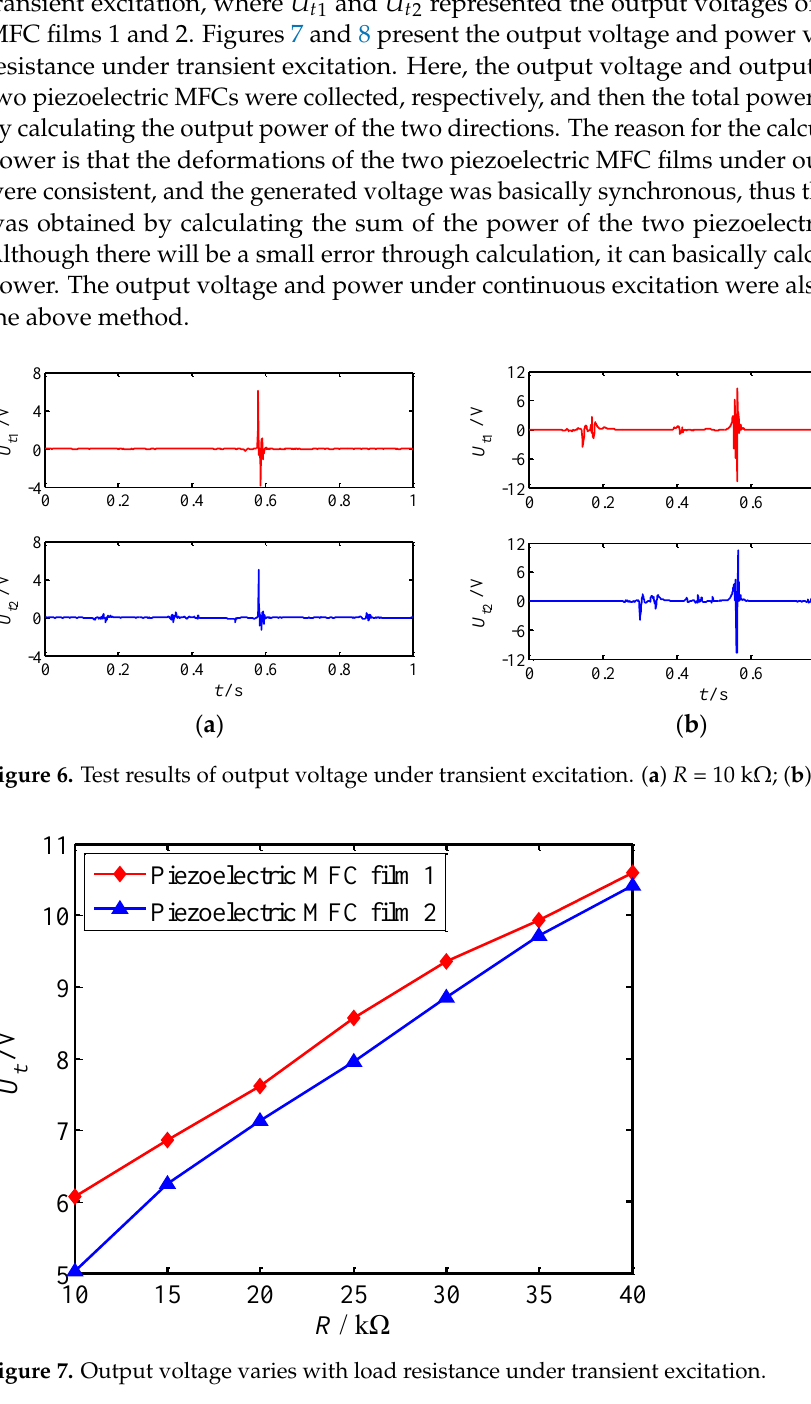
Figure 8. Output power varies with load resistance under transient excitation. From Figures 6–8, it can be observed that: (1) Under transient excitation, the output voltages of the micro-power piezoelectric generator are instantaneous. The voltage responses of the two piezoelectric MFC films are generated at the same time under transient excitation, and the amplitudes of the voltage response are slightly different. (2) As the load resistance increases, the output voltages of the micro-power piezoe- lectric generator increase. The output voltage of piezoelectric MFC film 1 pasted on the lower surface of the flexible strip is slightly higher than that of piezoelectric MFC film 2 on the upper surface. (3) The power change of the piezoelectric generator is relatively stable under in- stantaneous excitation. The stability of output power of piezoelectric MFC film 2 is higher than that of piezoelectric MFC film 1. The maximum total power occurs at a load of 10 kΩ, which is 6.2 mW. In addition, the output characteristics of the proposed micro-power piezoelectric generator under continuous excitation were studied. The variation law of the output